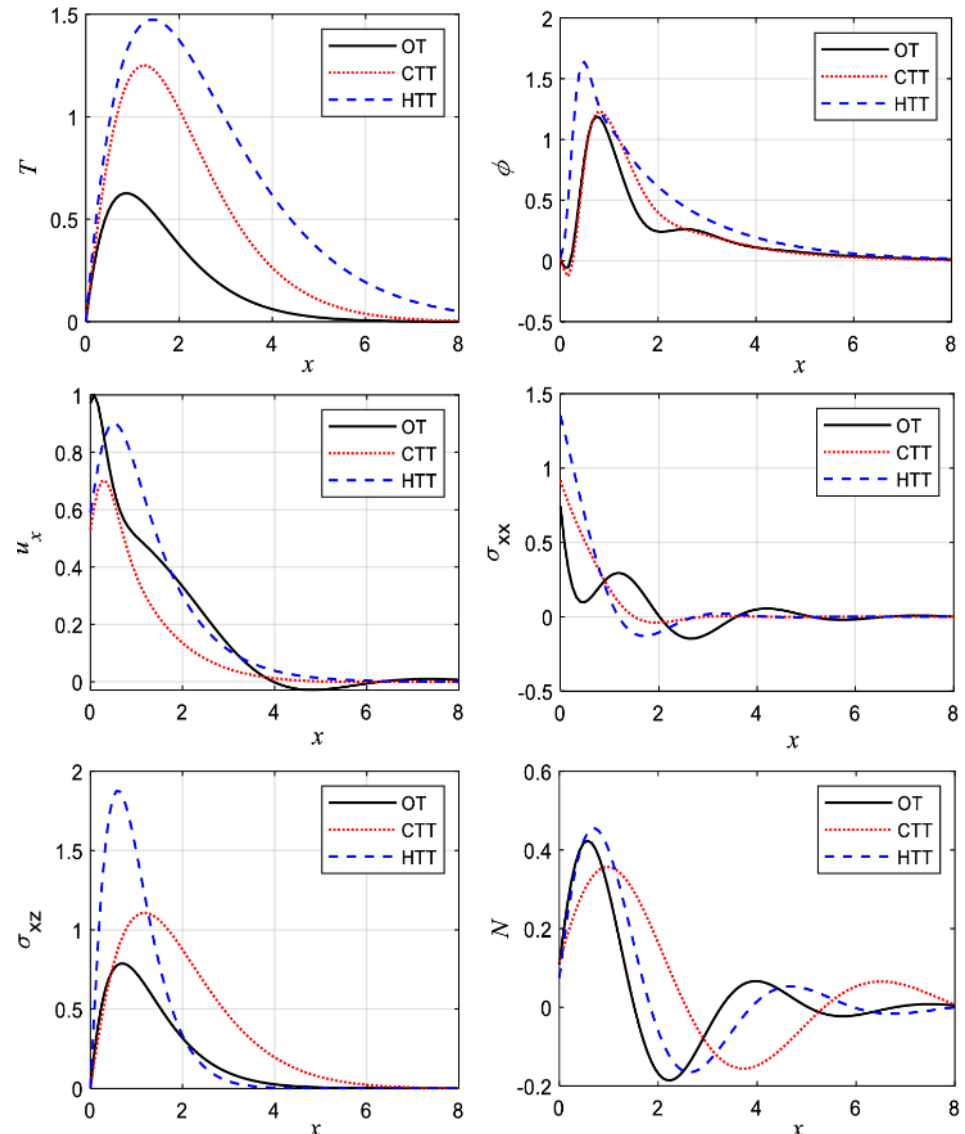
Figure 9. The main physical fields against the horizontal distance in generalized GL model with laser pulses and magnetic field in one temperature, two temperatures, and hyperbolic two temperatures [63]; with permission from